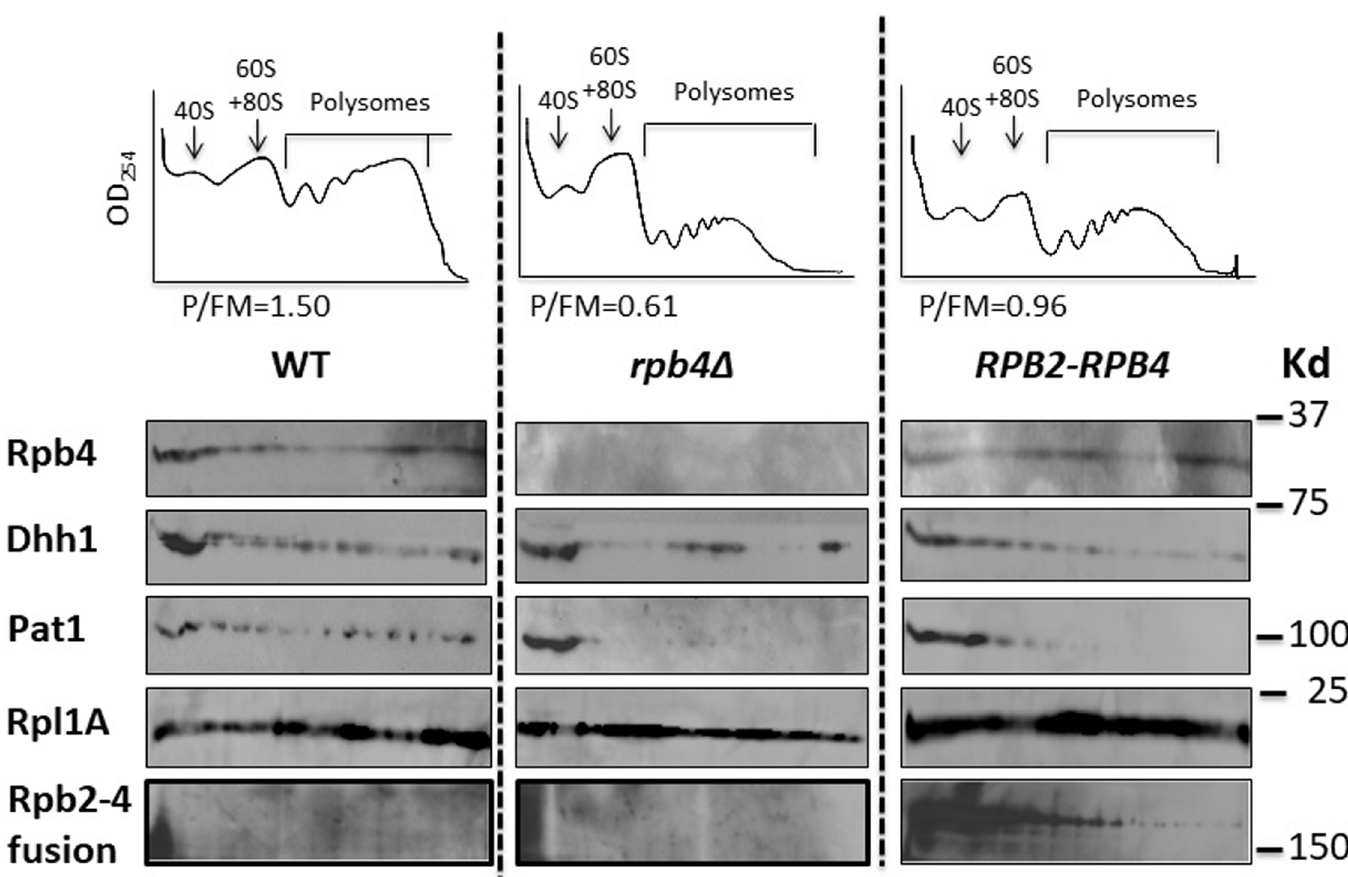
Fig 4. Association of the Rpb2-Rpb4 fusion protein and free Rpb4 with polysomes. Extracts from the indicated strains were subjected to polysomal fractionation as indicated in the Materials and methods [18]. Upper panel: the polysomal profiles for each strain. The ratio between polysomal RNA and free RNA + monosomal RNA (designated P/FM) is depicted below each profile [18]. Lower panel: The fractions were analyzed by Western blotting, using the indicated antibodies, to detect the polysomal marker Rpl1A, the translation factors Dhh1 (Dhh1 pattern is disrupted in some lanes due to inefficient blotting) and Pat1 as well as free Rpb4 and Rpb2-Rpb4 fusion proteins. Both the free Rpb4 and the fusion protein were detected by anti-Rpb4 Abs. To better detect the free Rpb4, twice as much protein was loaded per lane of the RPB2-RPB4